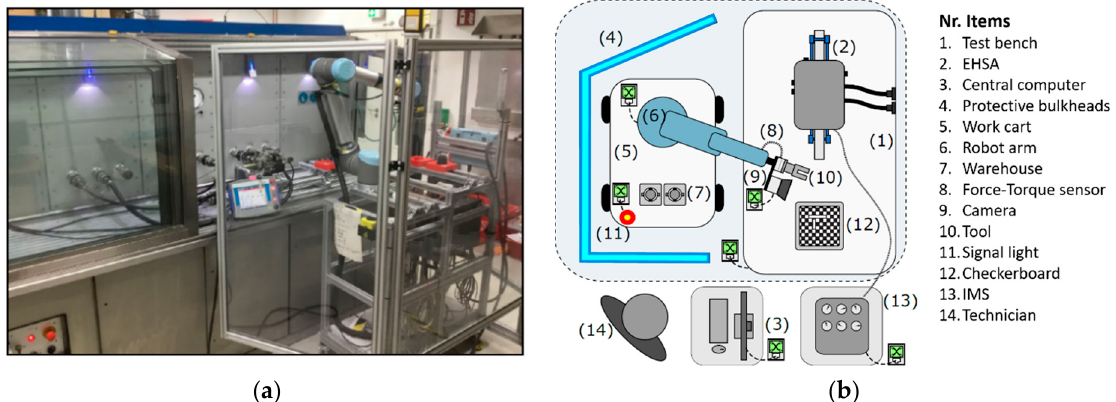
Figure 2. ( a ) Test bench used for testing new maintenance procedures on EHSAs using a UR10 collaborative robot; ( b ) Schematic overview of the setup adopted during the experimental